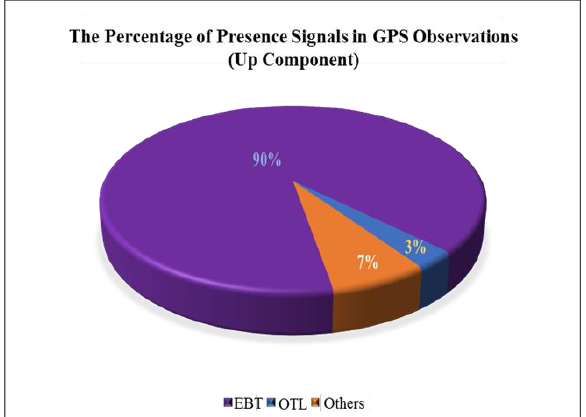
Figure 6. The average of presence signals in GPS observations at up